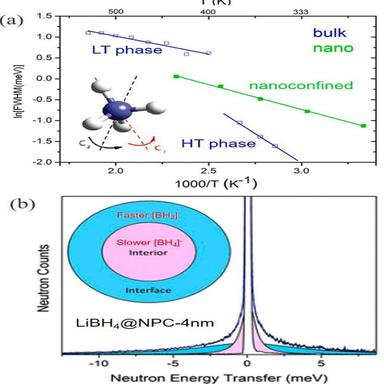
(a) Quasielastic broadening with temperatures for bulk and nano LiBH4. Width Γ of the quasielastic contribution measured in bulk and nanoconfined LiBH4. The temperature dependence of the quasielastic broadening Γ follows the Arrhenius law, typical for a thermally activated behavior; (b) QENS spectrum of LiBH4 @ NPC-4 nm at 3 Å−1 momentum transfer and 400 K.